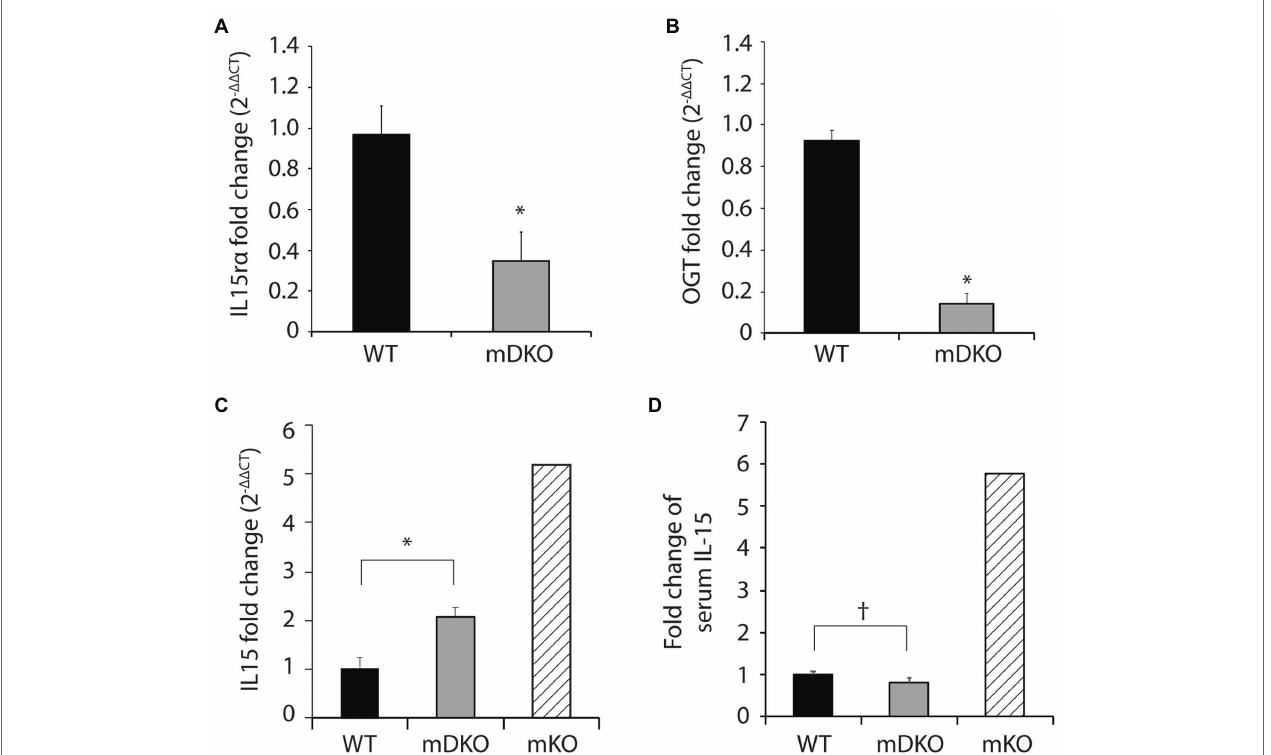
FIGURE 1 | O-GlcNAc transferase (OGT) and interleukin-15 (IL-15)r α double knockout in skeletal muscle perturbed elevated IL-15 secretion. (A–C) Relative gene expression of (A) IL-15r α (B) OGT, and (C) IL-15 in the gastrocnemius muscles of WT and mDKO mice fed with a HFD for 22 weeks, n = 7. (D) Serum IL-15 levels in WT and mDKO mice fed a HFD for 22 weeks, n = 8. Values are normalized to WT means. * p < 0.05, † p < 0.08 when compared to WT. Values of striped bars are means from 5 muscle-specific OGT knockout mice (mKO) for